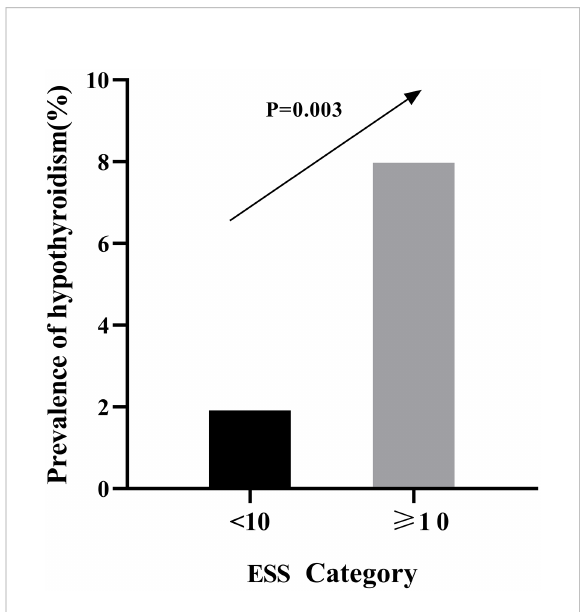
FIGURE 4 Prevalence of hypothyroidism by category of ESS in men patients with